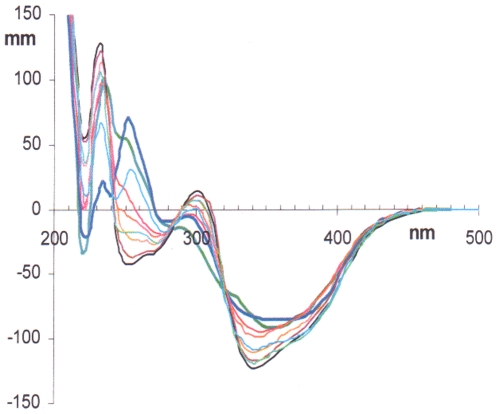
CD spectra for biisocolchicide in MeCN/H2O mixtures of various compositions.CD spectra for biisocolchicide 5 in MeCN/H2O mixtures of various composition are reported; ____: neat H2O; ____: neat MeCN (bold lines); elongations are in mm.